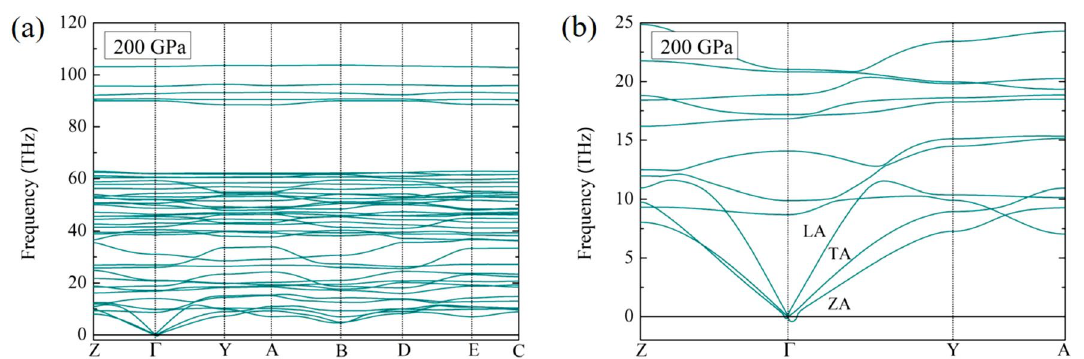
Figure 3. ( a ) The phonon dispersion of the Pm structure at a pressure of 200 GPa. ( b ) The soft-mode at the Ŵ –point of the Pm structure at a pressure of 200